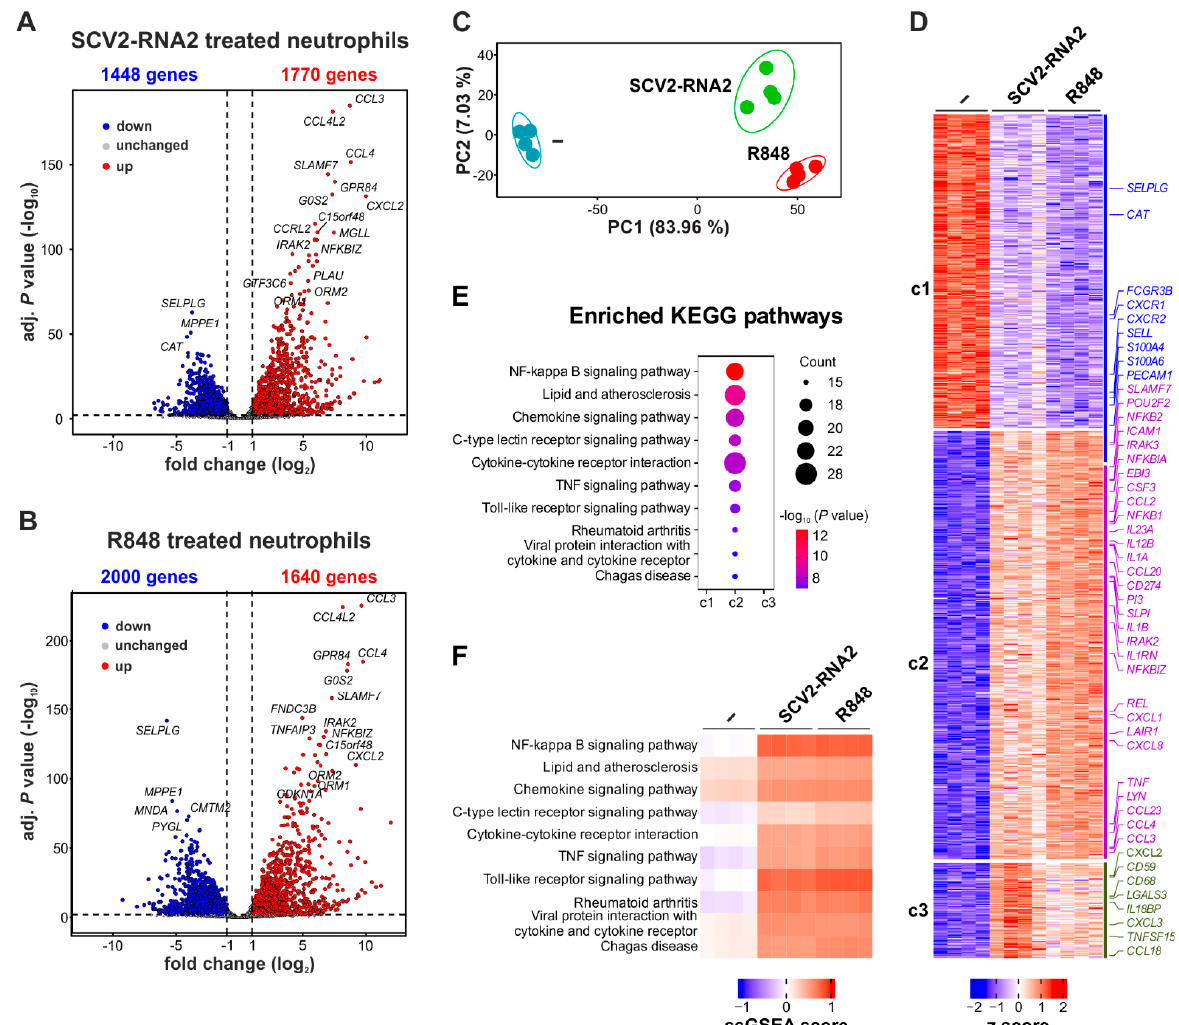
Figure 3. Gene expression profile of neutrophils treated with SCV2-RNA2 or R848. ( A , B ) Volcano plot displaying differentially expressed genes (DEGs) in neutrophils incubated with SCV2-RNA2 ( A ) or R848 ( B ) for six hours. Each dot in the plot represents a single DEG. DEGs showing significantly increased or decreased expression ( p < 0.01, calculated by Wald’s test) are marked by red and blue dots, respectively, while genes not significantly modulated by stimulation are shown as grey dots. ( C ) A PCA scatterplot based on the DEGs identified among neutrophils incubated with or without SCV2-RNA2 or R848 for six hours. Blue, red, and green circles represent, respectively, samples from resting, R848-stimulated, and SCV2-RNA2-stimulated cells (n = 4). ( D ) Heatmap displaying the expression patterns of the gene clusters (c1–c3) resulting from the k-means clustering analysis of DEGs. Relative expression levels for a single transcript were calculated by z score. Selected genes of each cluster are depicted on the right y axis. ( E ) KEGG pathways enriched by genes associated with the gene cluster c2. No statistically significant enriched KEGG pathways were present in c1 and c3. The top 10 KEGG pathways with Benjamini–Hochberg-corrected p values <0.05 (one-sided Fisher’s exact test) are shown. ‘Counts’ indicate the fraction of DEGs present in the given KEGG pathway. ( F ) Heatmap representations of gene set variation analysis (GSVA) comparisons among untreated and SCV2-RNA2- or R848-treated neutrophil. Gene set signatures were obtained from KEGG pathways enriched in c2 ( E ). Color intensity of the squares is indicative of the GSVA score, which varies from 1 (maximal signature enrichment, indicated by red) to − 1 (absent signature enrichment, indicated by blue) .